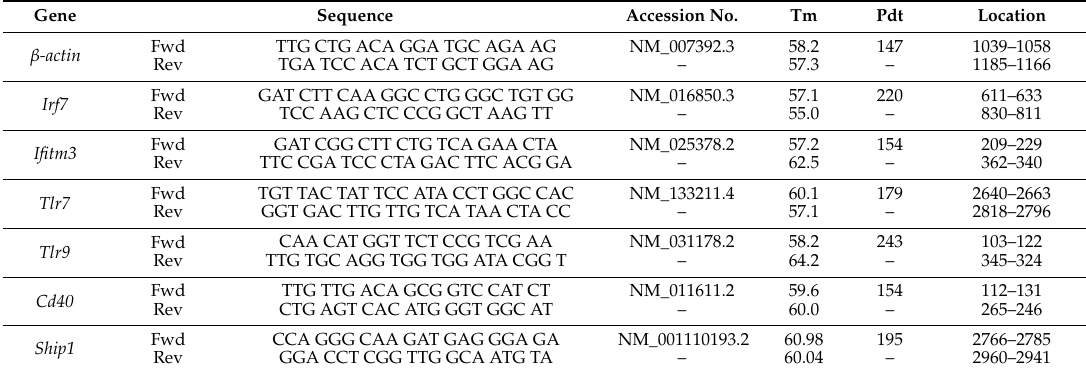
Table 1. List of primers used in this